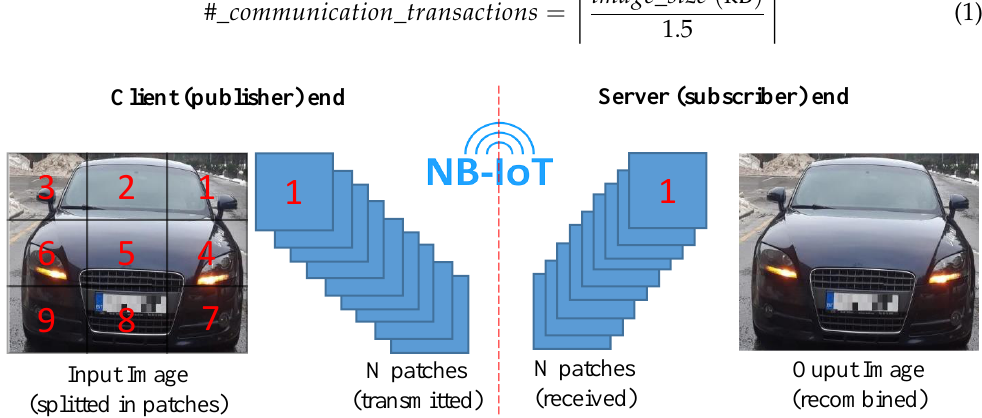
Figure 8. Splitting of an image into patches (at the publisher end) and its reconstruction (at the server end)